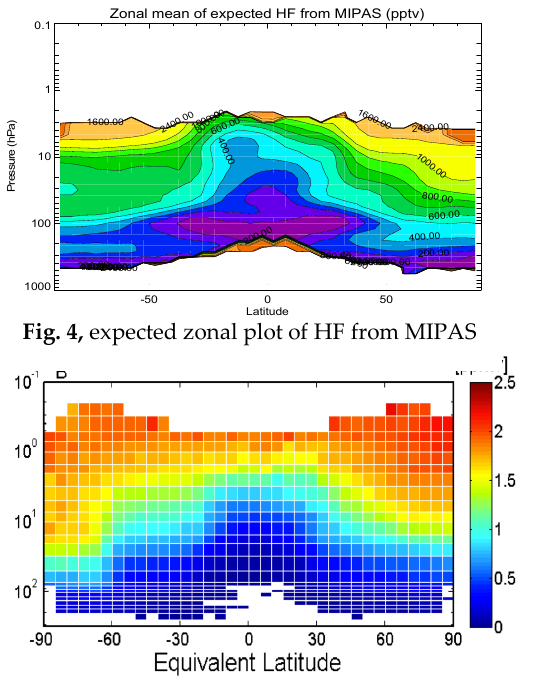
Fig. 5, zonal plot of HF from ACE-FTS (Jones et al., 2012)